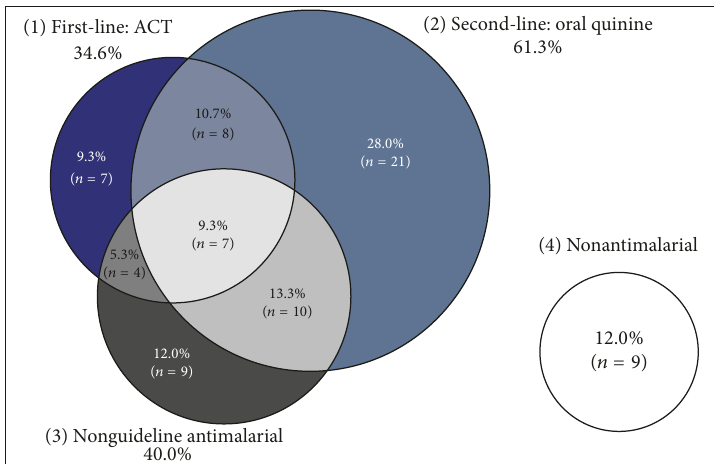
Figure 5: What vendors routinely recommend for the treatment of malaria in children aged five and under. Drug vendors provided multiple